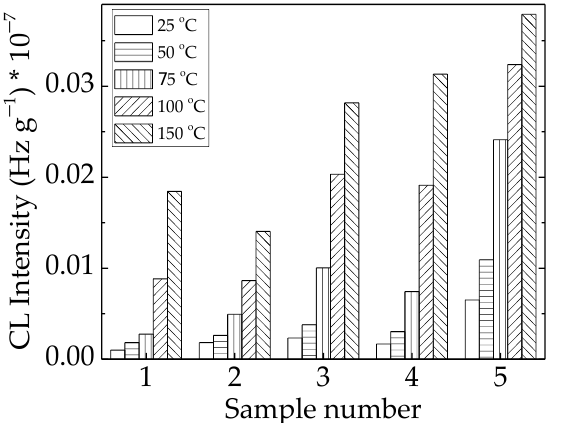
Figure 6. Histogram of CL intensities measured for LDPE/UHMWPE probes irradiated at 25 kGy. (1) LDPE/UHMWPE; (2) LDPE/HAp; (3) LDPE/HAp/RM; (4) LDPE/UHMWPE/HAp; (5) LDPE/UHMWPE/HAp/RM.